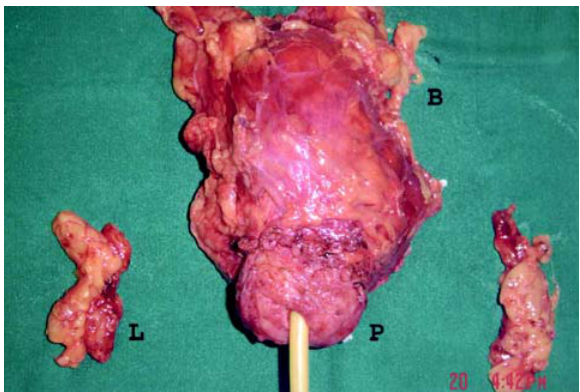
Figure 1 – Photograph showing intact surgical specimen: blad- der (B), prostate (P) and lymph nodes (L).